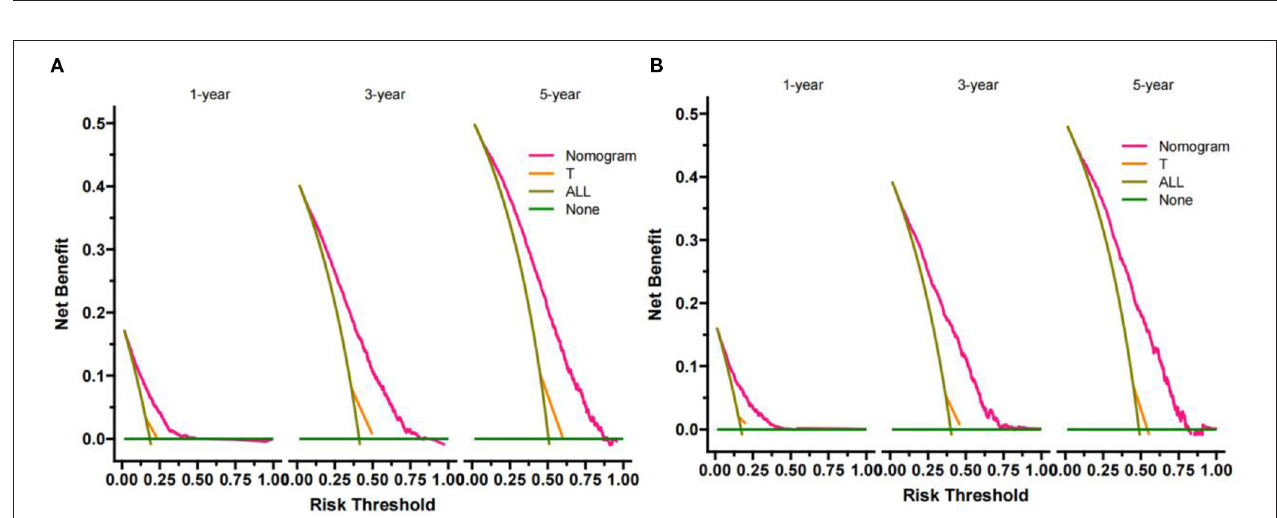
FIGURE 4 | AUC for predicting 1-, 3-, and 5-year CSS in training cohort (A) and validation cohort (B) .